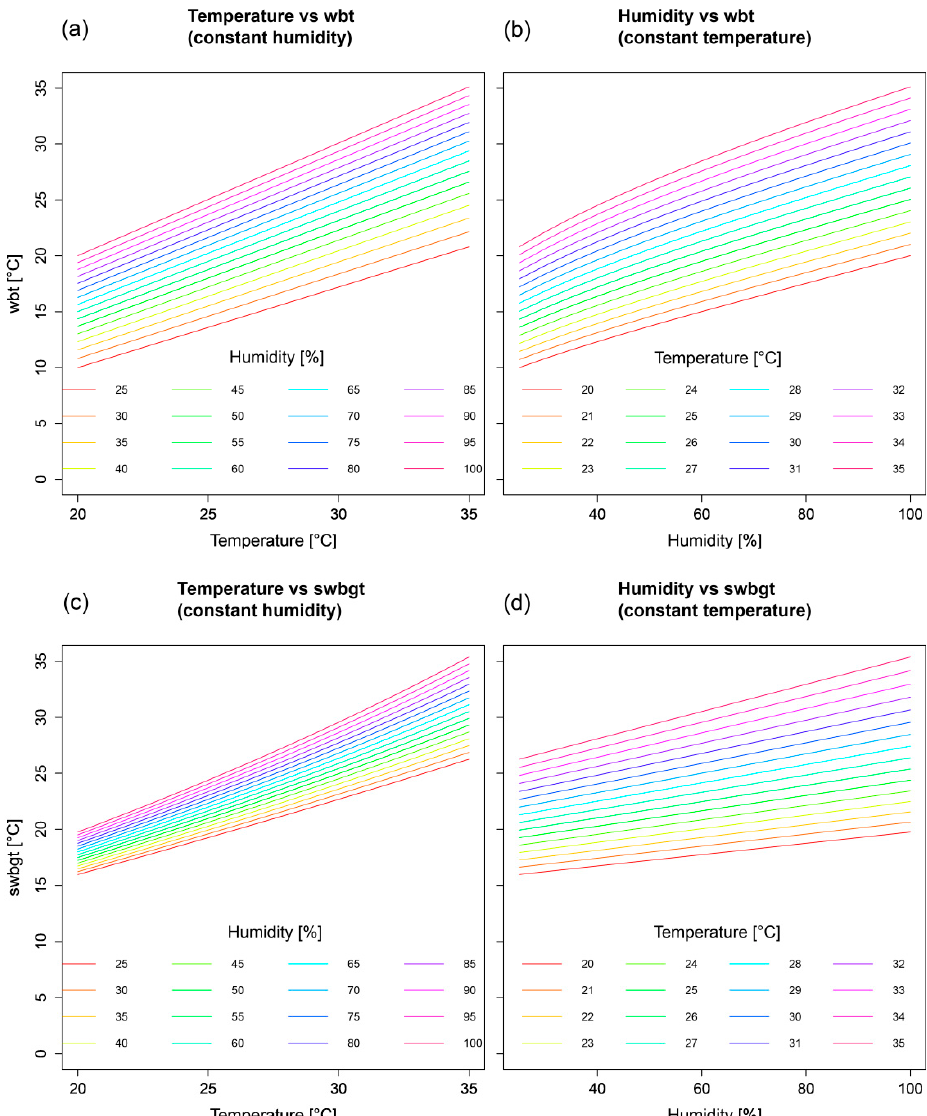
Figure 8. Response surface analysis of wbt ( a , b ) and swbgt ( c , d ).